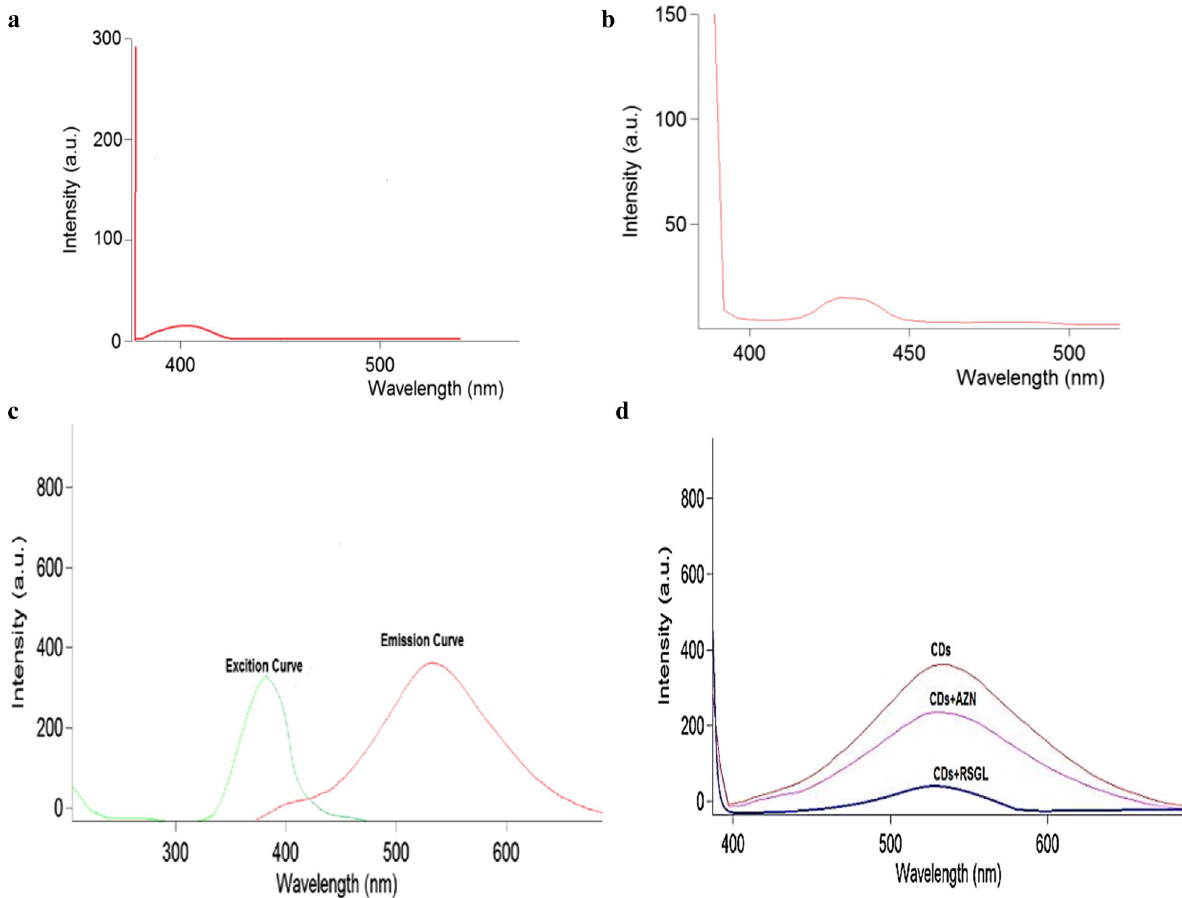
Fig. 3 Fluorescence emission of a 0.1 μg/mL AZN, b 5 μg/mL RSGL, c Overlay for excitation and emission curves of CDs and d Quenching of CDs fluorescence emission in the presence of 0.001 μg/mL AZN and 0.25 μg/mL